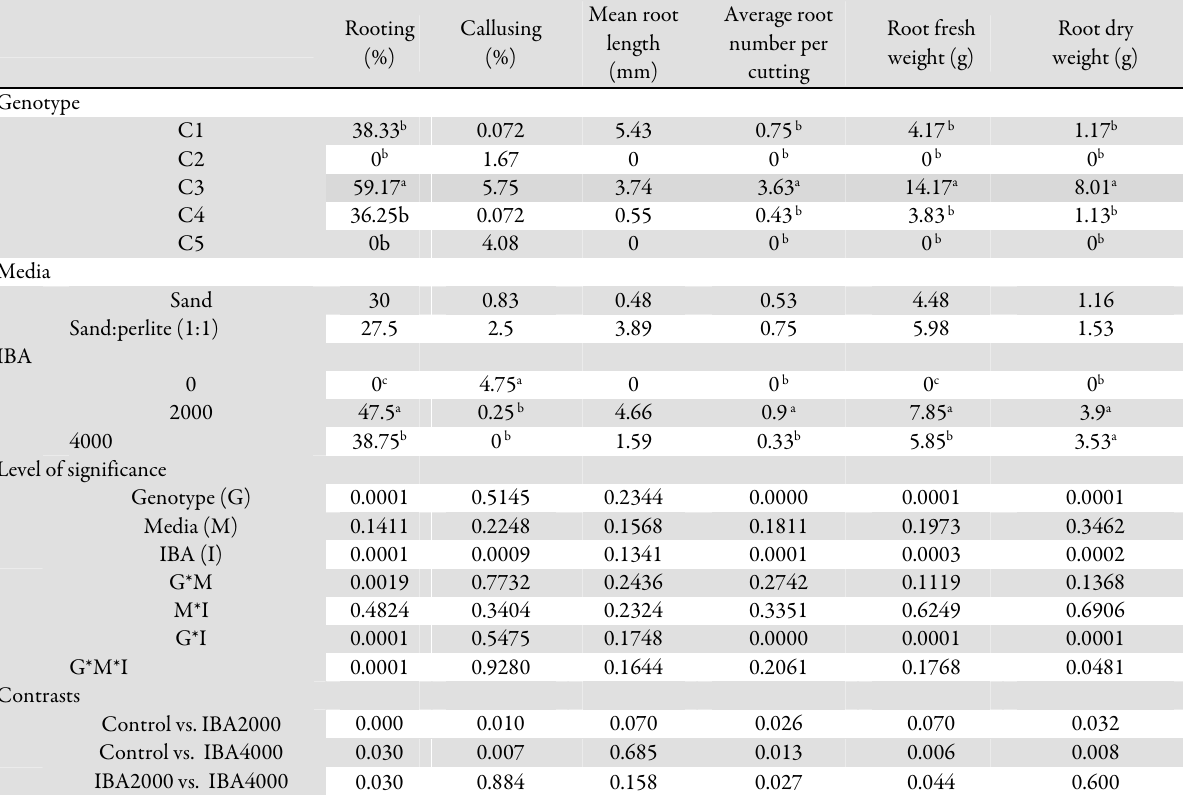
Tab. 1. Mean values of rooting response of Cornus mas cuttings